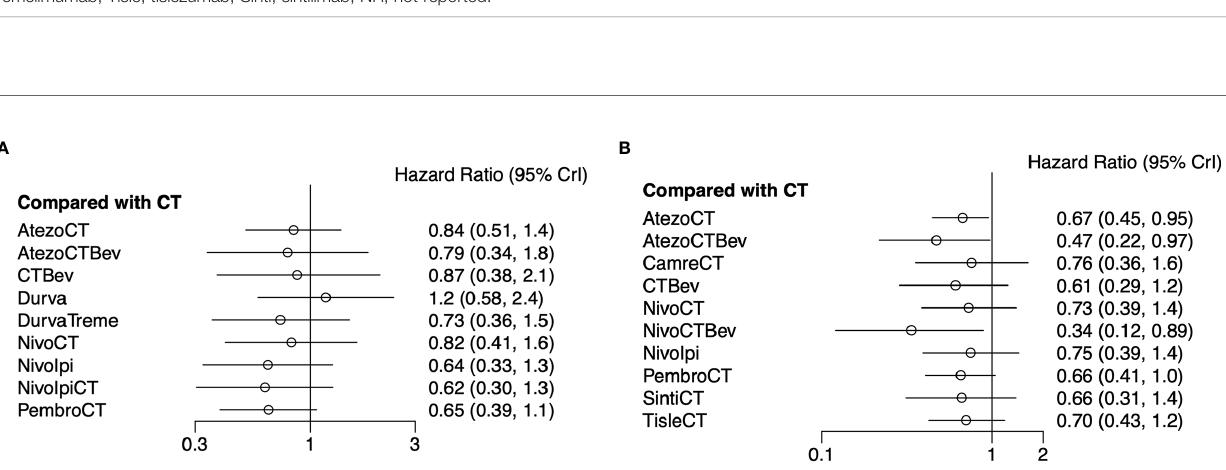
FIGURE 2 | Network plot for effectiveness of 10 and 9 different treatment modalities for patients with PD-L1 – negative expression for OS (A) and PFS (B) , respectively. Circles represent the intervention as a node in the network and their size is proportional to the number of included studies; lines represent direct comparisons within the frame of randomized clinical trials (RCTs); the line thickness indicates the number of RCTs included in each comparison. CT, chemotherapy; Atezo, atezolizumab; Bev, bevacizumab; Nivo, nivolumab; Ipi, ipilimumab, Pembro, pembrolizumab; Carem, caremlizumab; Durva, durvalumab; Treme, tremelimumab; Tisle, tislezumab; Sinti, sintilimab; NR, not